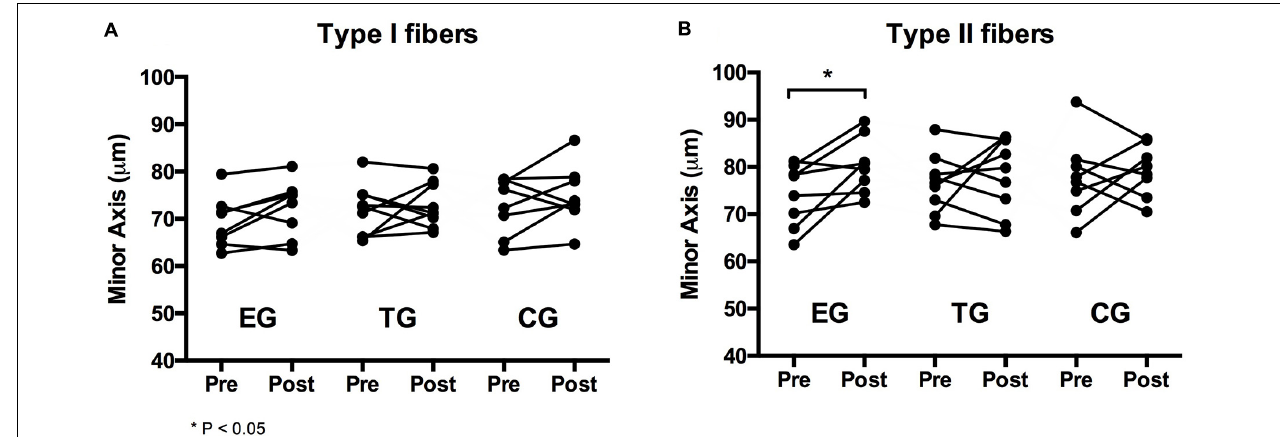
FIGURE 4 | Individual changes in myofiber diameter of (A) type I and (B) type II fibers in the EMS-Group (EG), Training-Group (TG), and Control-Group (CG) measured 2 weeks before (Pre) and after the intervention period (Post).